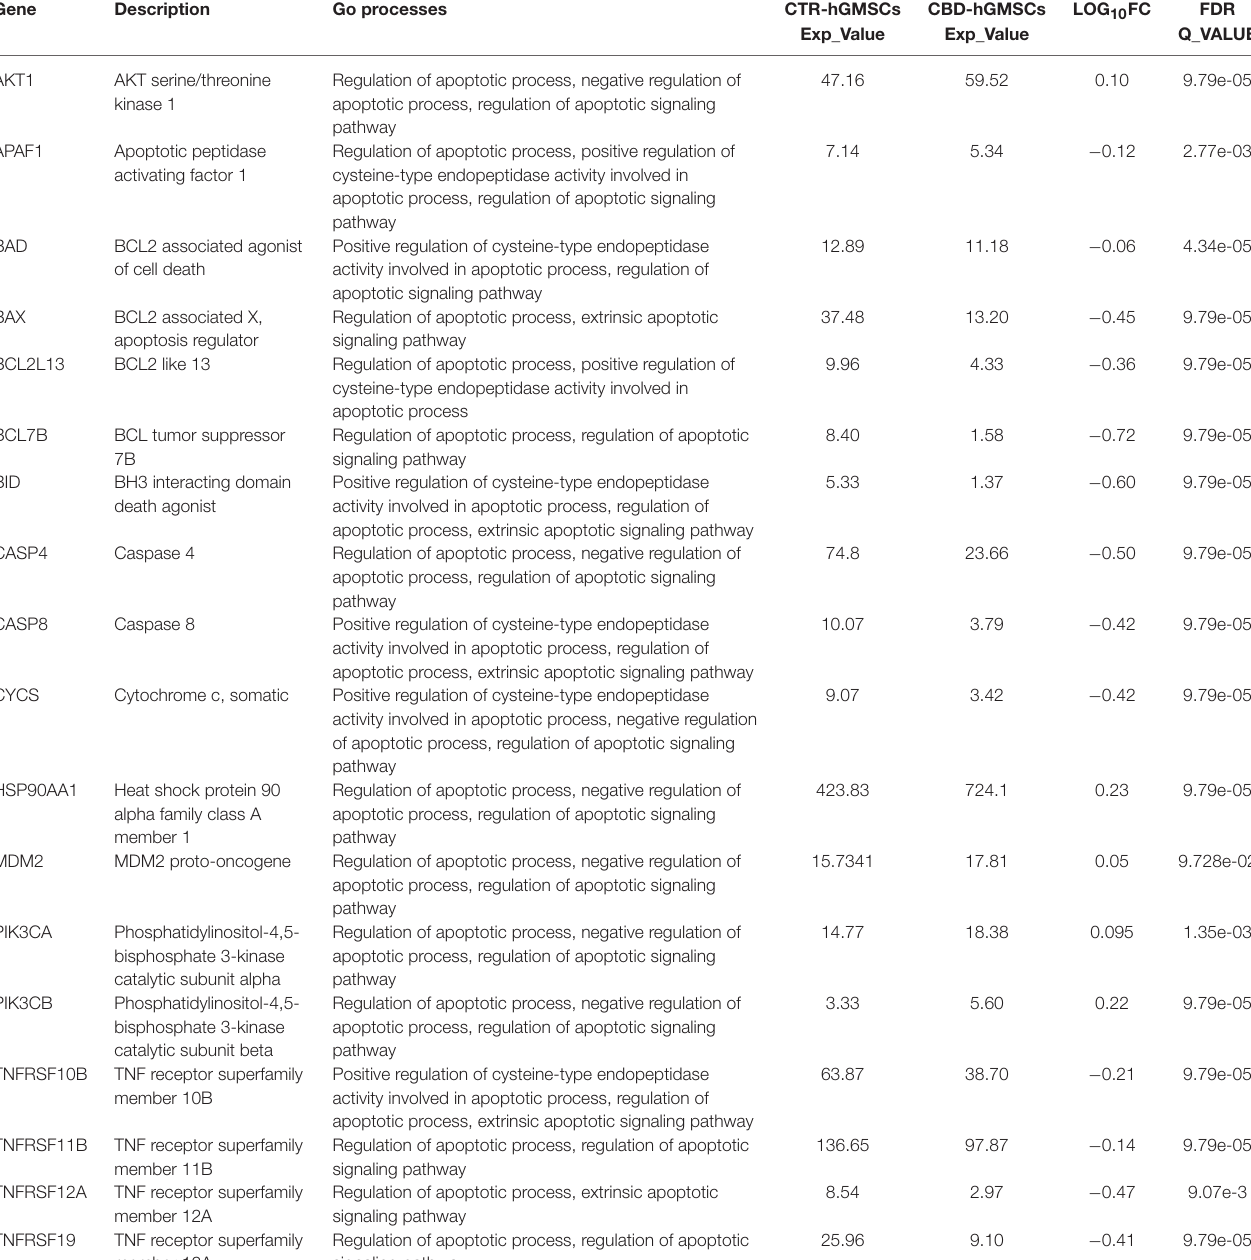
TABLE 3A | CBD treatment reduced the expression of pro-apoptotic genes. Gene